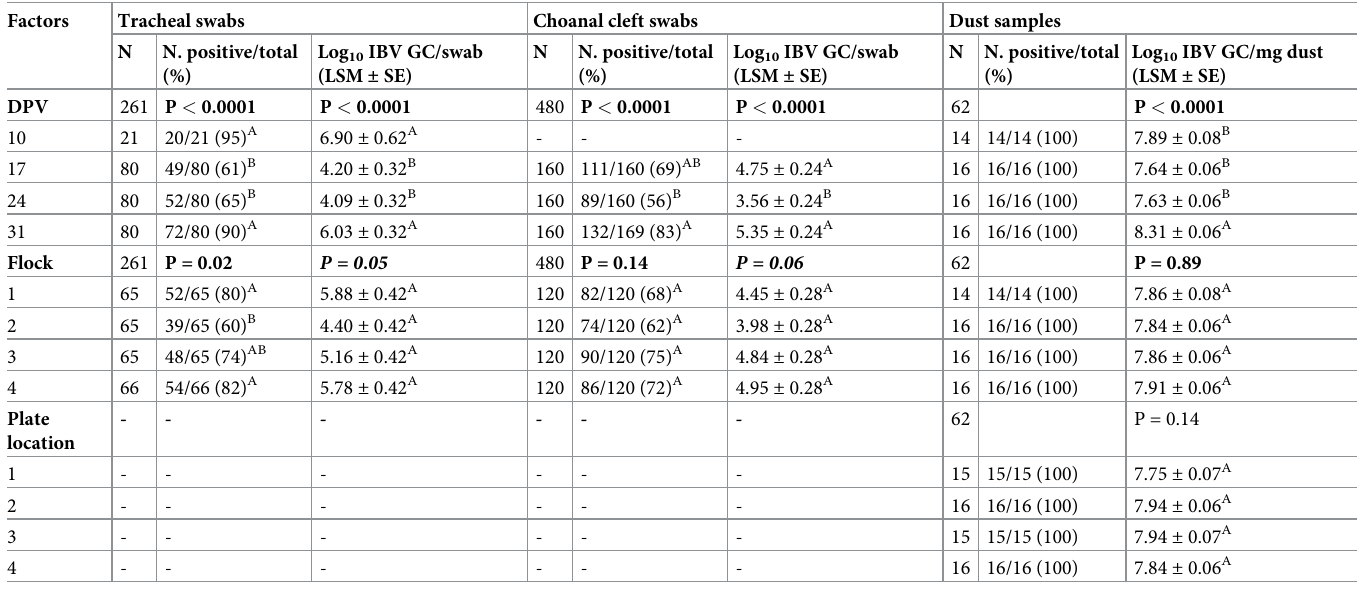
Table 1. Proportion of IBV positive samples and log 10 GC/mg of dust or per swab (LSM ± SEM) in tracheal and choanal cleft swabs and dust samples collected from different flocks at different days post vaccination.